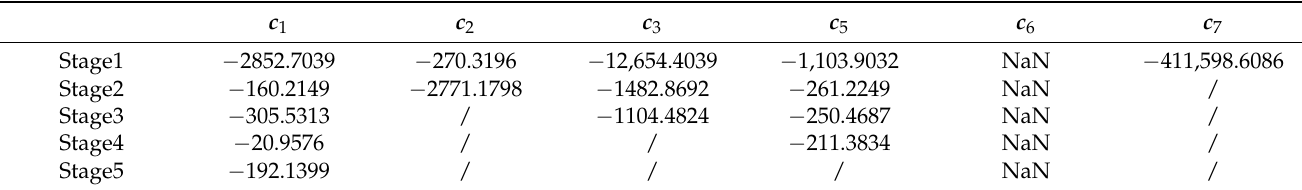
Table 10. Values of fitness function at different stages of the glass data set.